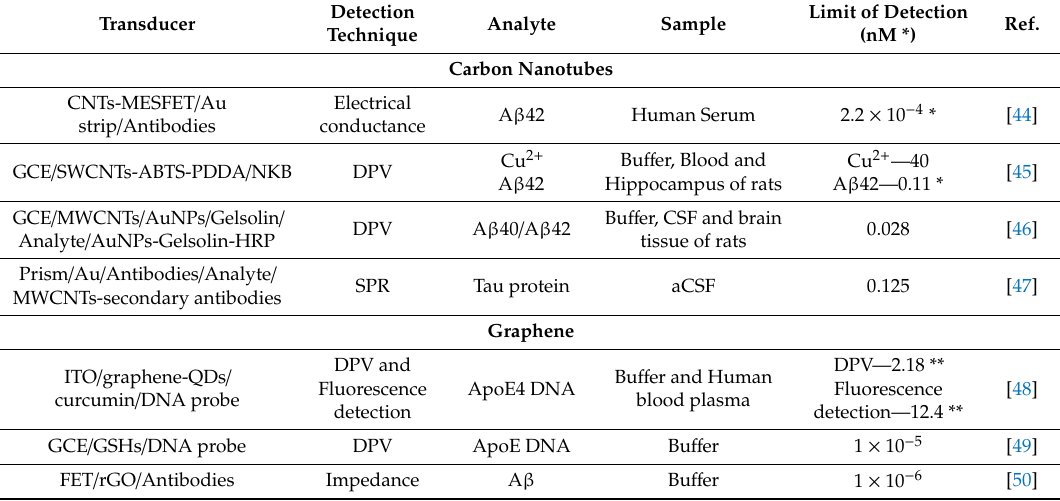
Table 1. Biosensors based on carbon nanomaterials for determination of Alzheimer’s disease (AD)